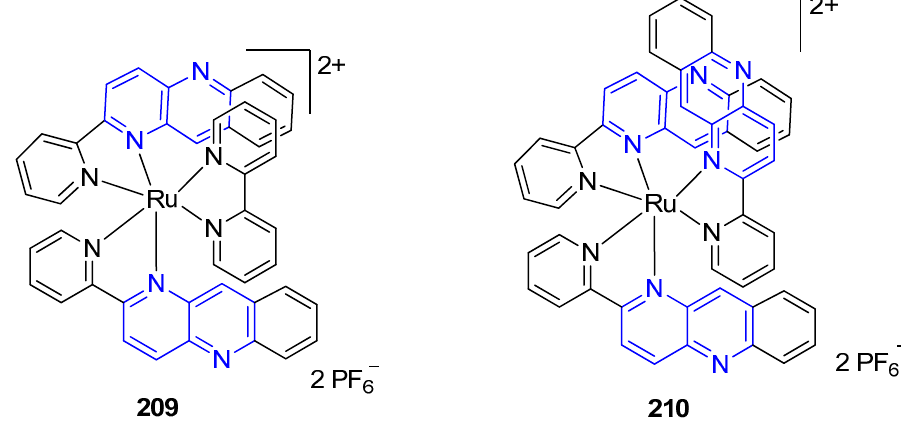
Figure 21. Ruthenium complexes containing fused 1,5-naphthyridines.